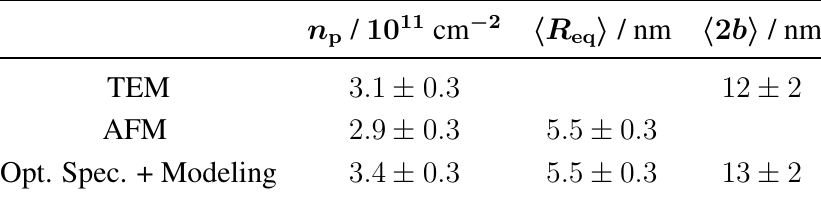
Table 1. AFM and optical spectroscopy versus